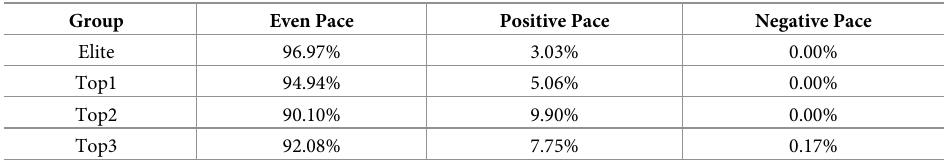
Table 4. Relation between pacing profiles and athletes‘group for men.